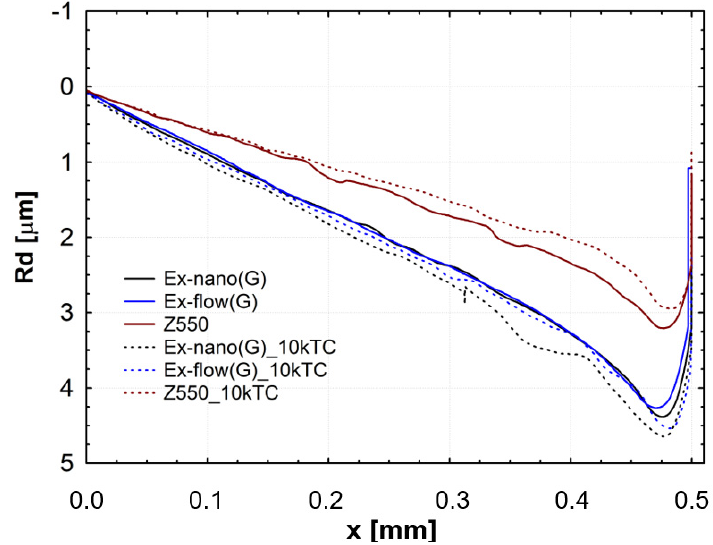
Figure 7. Mean curves of the indenter residual depth (R d ) as a function of the indenter position (x).